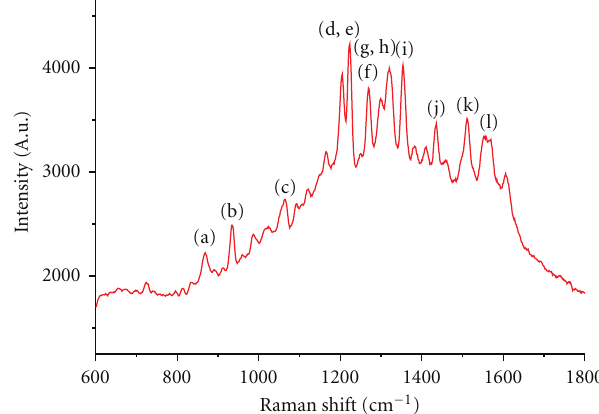
Figure 10: SERS signal from the detection of 0.1nM R6G using a LCPCF. Peaks (a) and (c) are from the citrate introduced during the synthesis of SNPs. Peaks (b), (d), (e), (f), (g), (h), (i), (j), (k), and (l) are typical R6G peaks. Specifically, (d) and (e) are split from the 1204cm − 1 peak while (g) and (h) are split from the 1312cm − 1 peak compared to the high concentration SERS